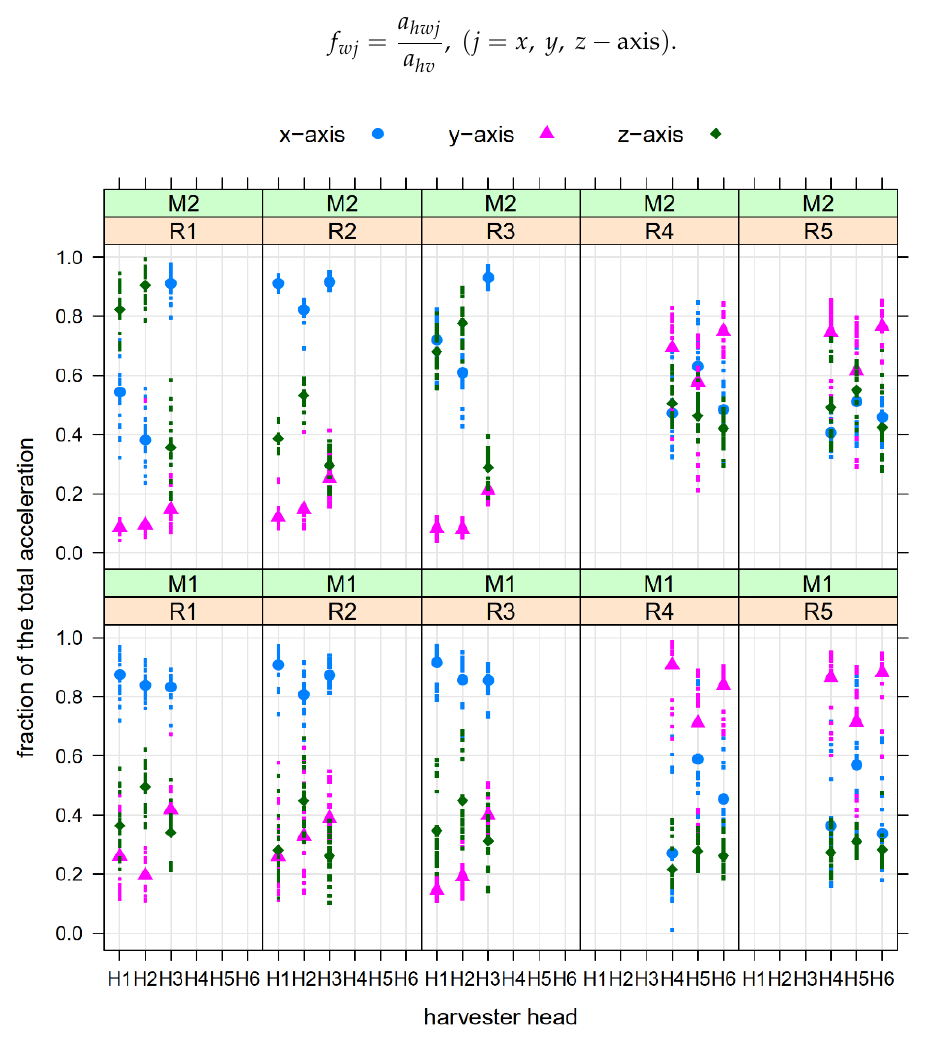
Figure 6. Fraction of the acceleration total value due to the components for each axis as affected by harvester head, rod, and measuring point (symbols represent mean values).